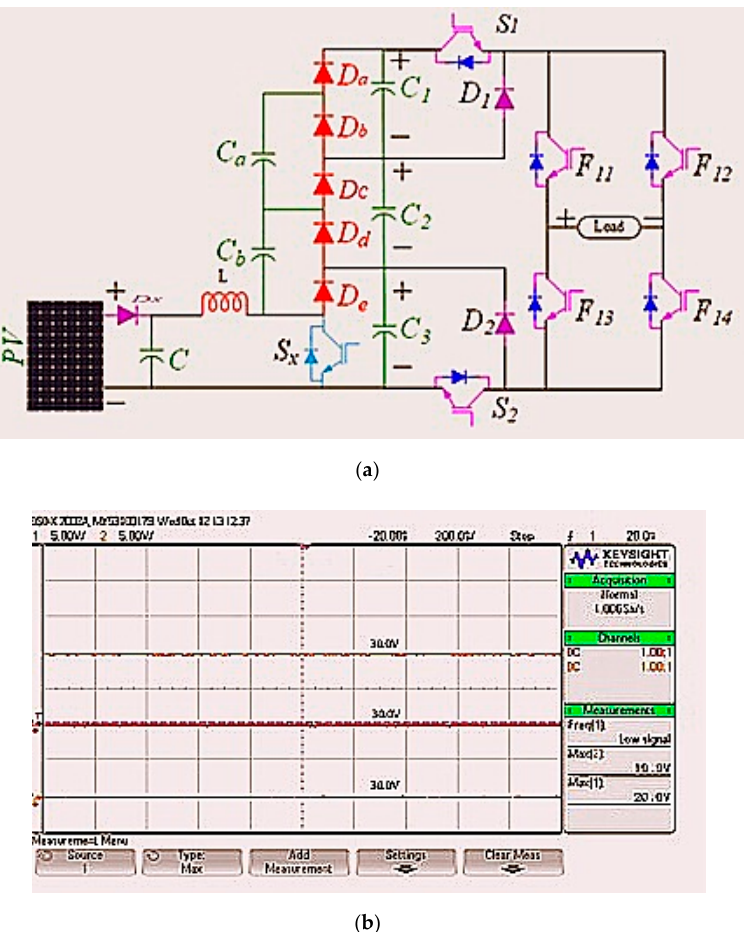
Figure 9. ( a ) Proposed seven-level inverter with voltage balancing circuit. ( b ) Proposed capacitor balancing circuit output voltage.